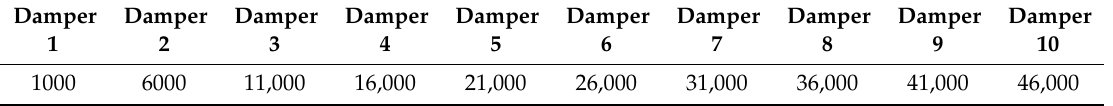
Table 3. Damping factors for optimum damping gradient of FE Table 3. D amping factors for optimum damping gradient of FE model.